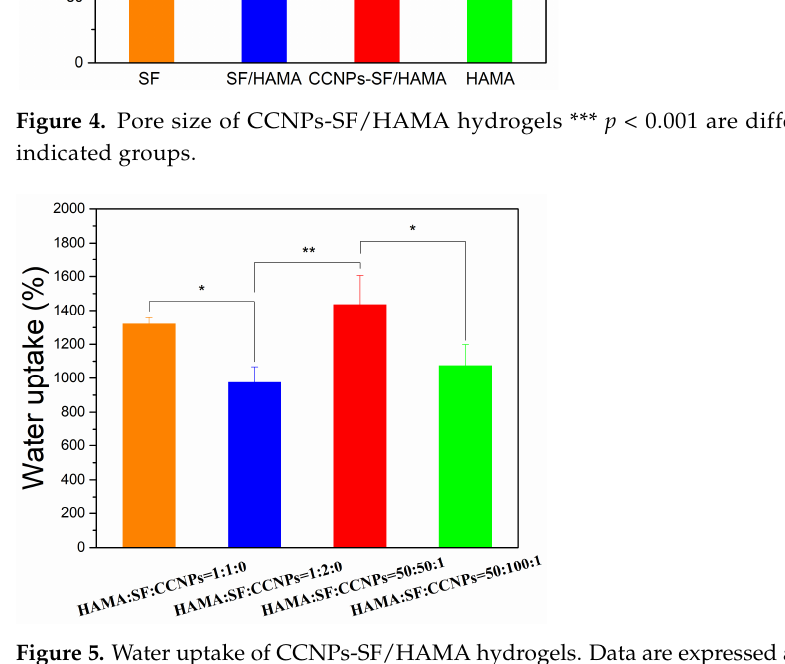
Figure 5. Water uptake of CCNPs-SF/HAMA hydrogels. Data are expressed as mean ± SD ( n = 4); * p < 0.05, and ** p < 0.01 are differences between the indicated groups.